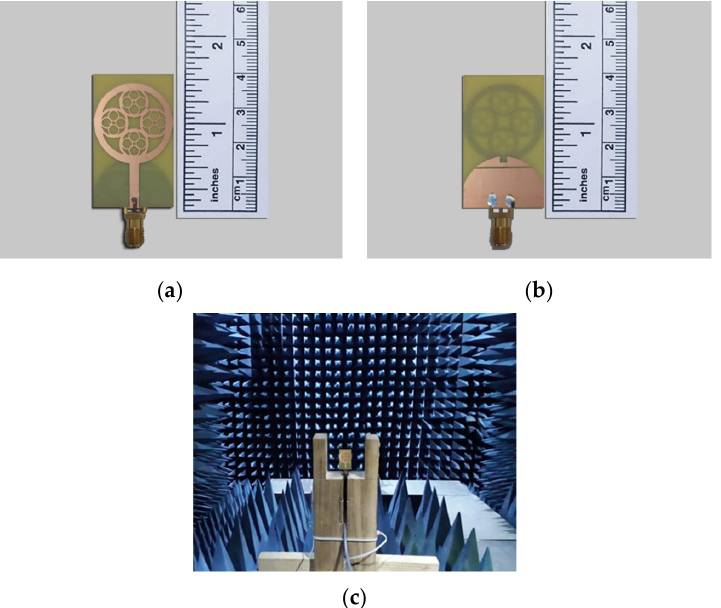
Figure 8. Patch prototype. ( a ) Top view, ( b ) boom view, and ( c ) installation for measuring radiation characteristics in the anechoic chamber. characteristics in the anechoic